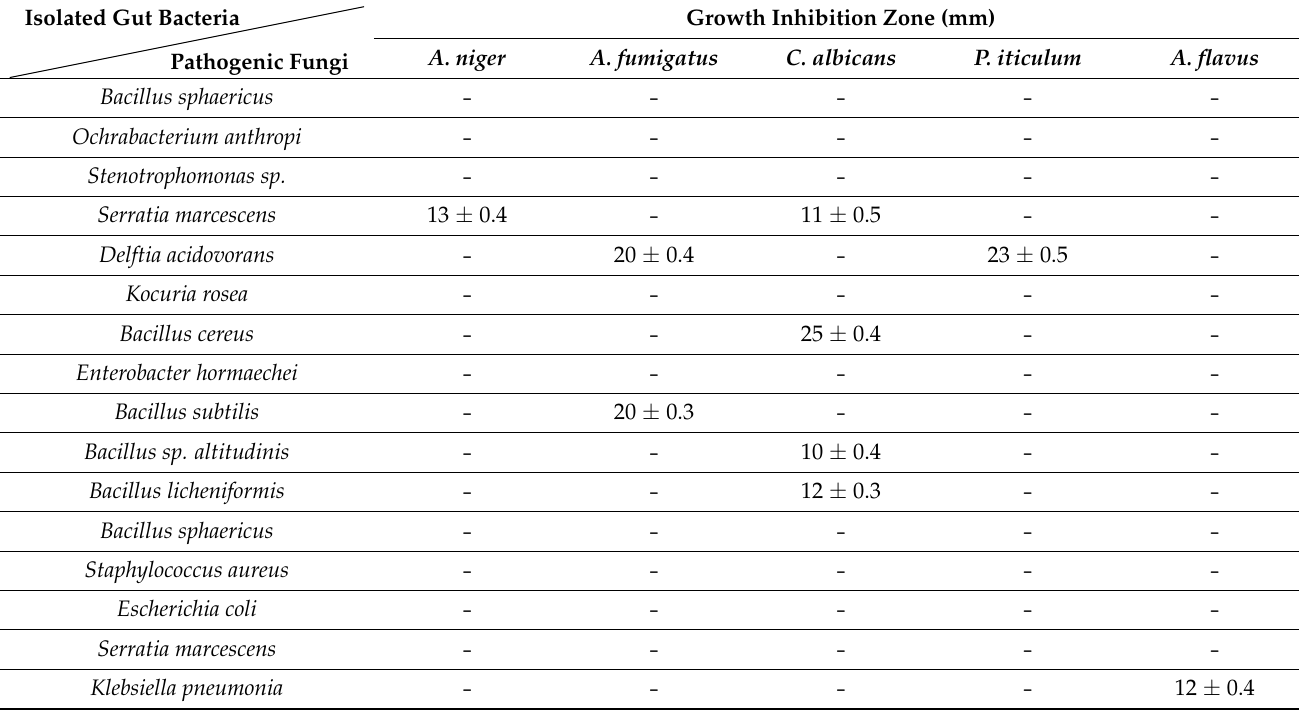
Table 3. Antagonistic activity of isolated gut bacteria against MDR fungi.